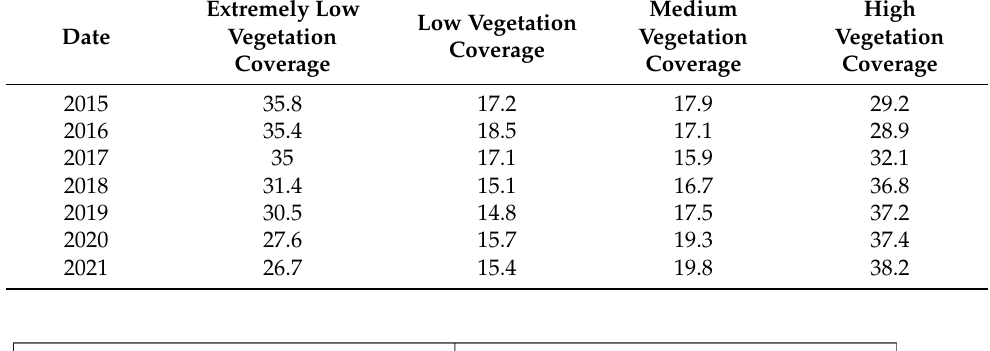
Figure 6. Variation of groundwater depth in the mainstream area of the Tarim River in 2021.